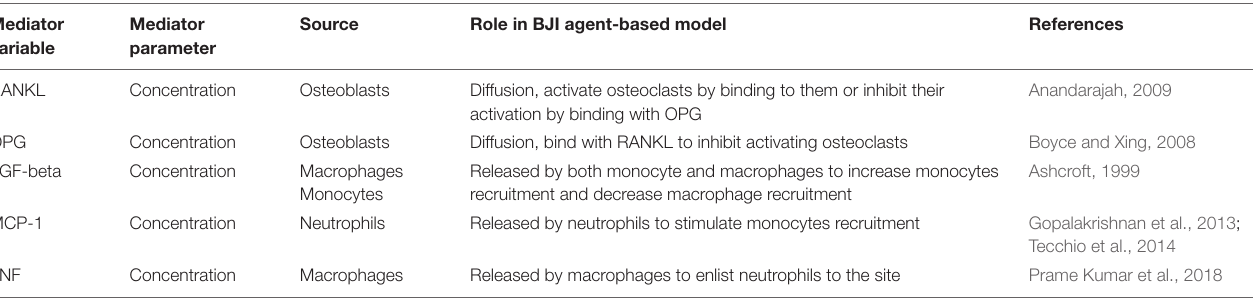
TABLE 2 | List of the mediators and their effects that are represented in the bone and joint infections